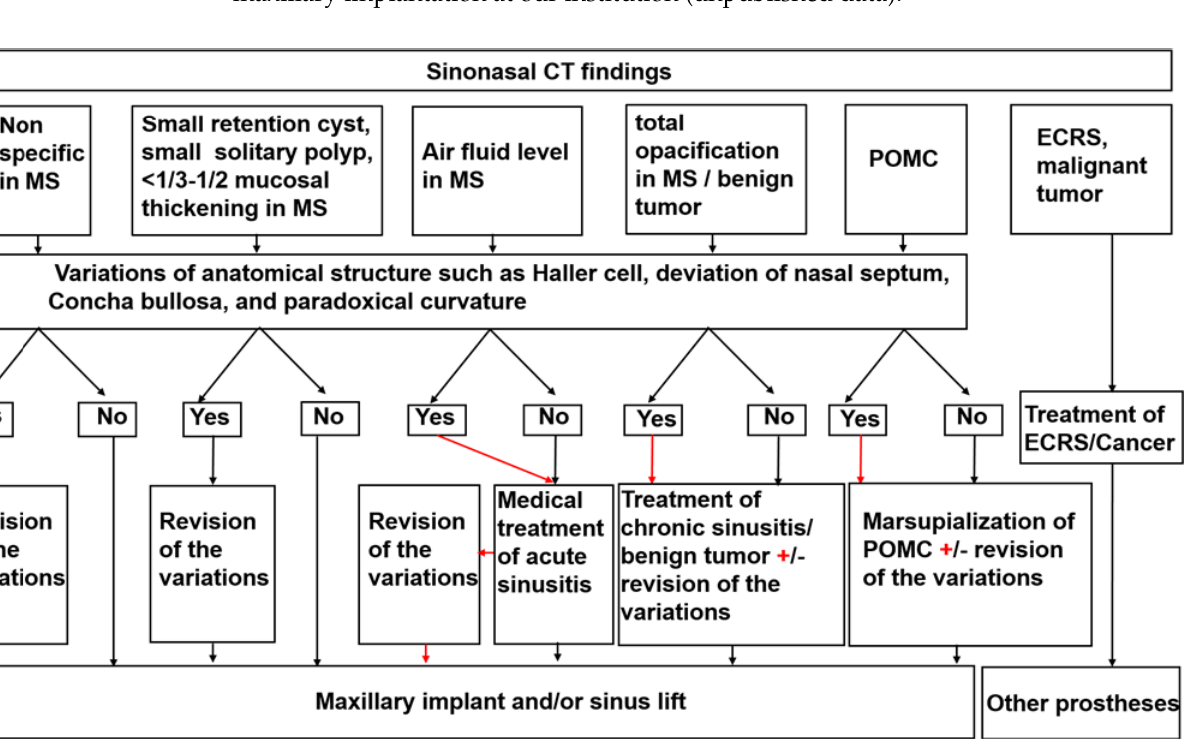
Figure 6. Evaluation and management protocol based on sinonasal CT findings.